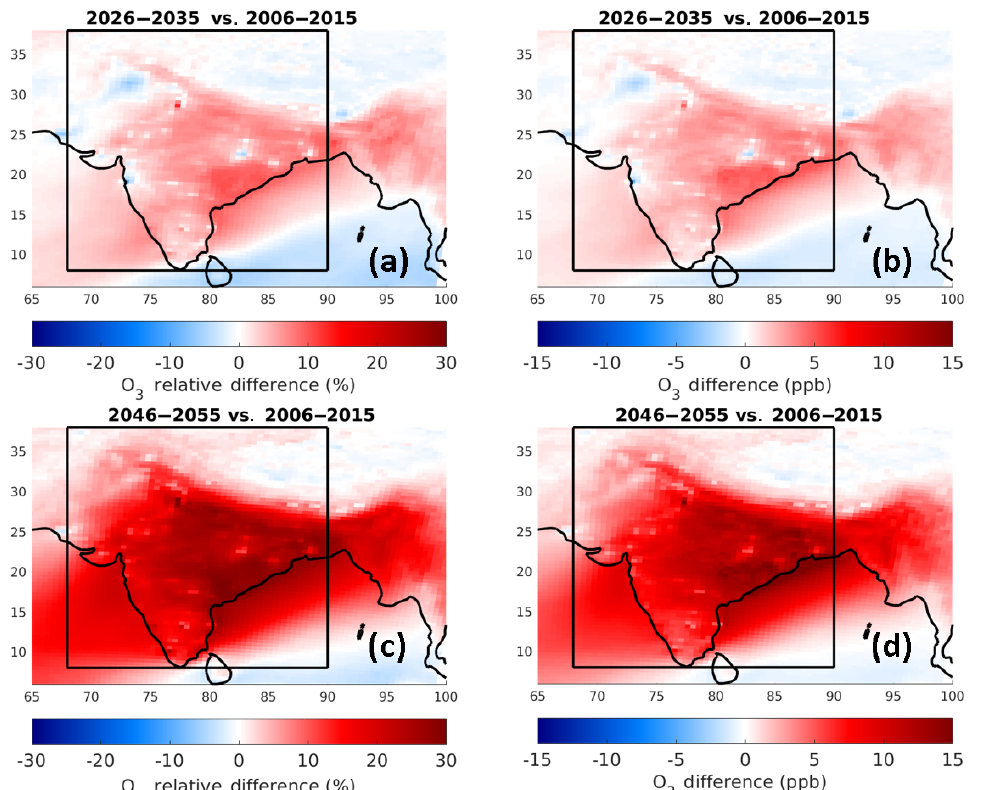
Figure 11. Distribution of the relative difference (a, c) and absolute difference (b, d) in surface O 3 between the reference and the FCE2030 scenario (a–b) and the FCE2050 scenario (c–d) . The relative differences are calculated as ([FCE– reference] / reference) × 100%, and the absolute differences as [FCE – reference]. The black box delimits the region described in the